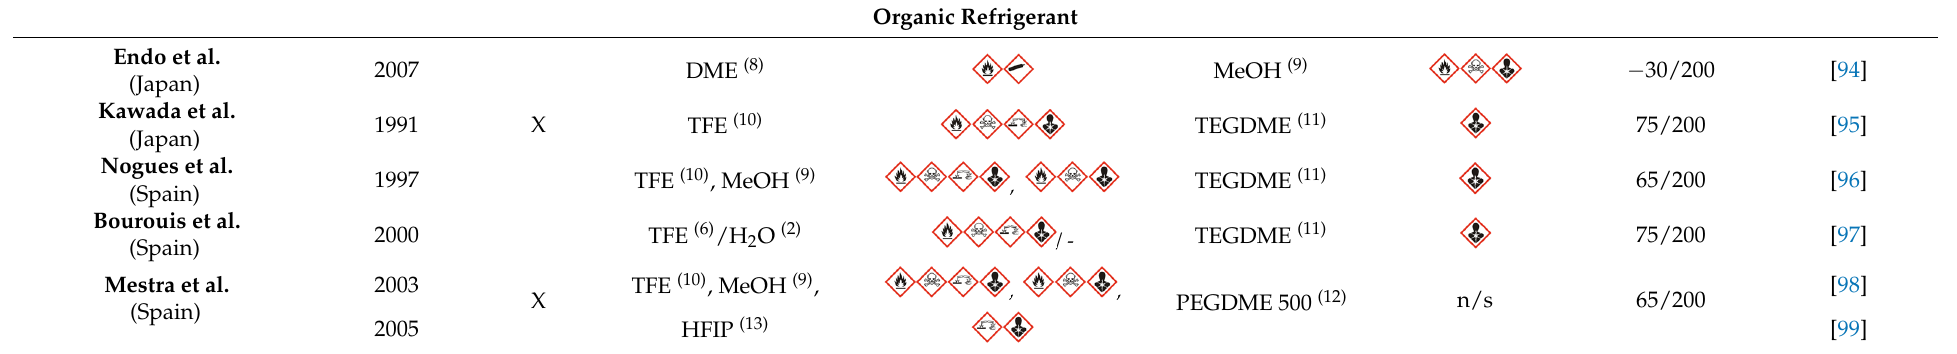
Chemicals; T min /T max : Applicable temperature range; n/s: not specified; CAS: Chemical Abstracts Service; MAK: